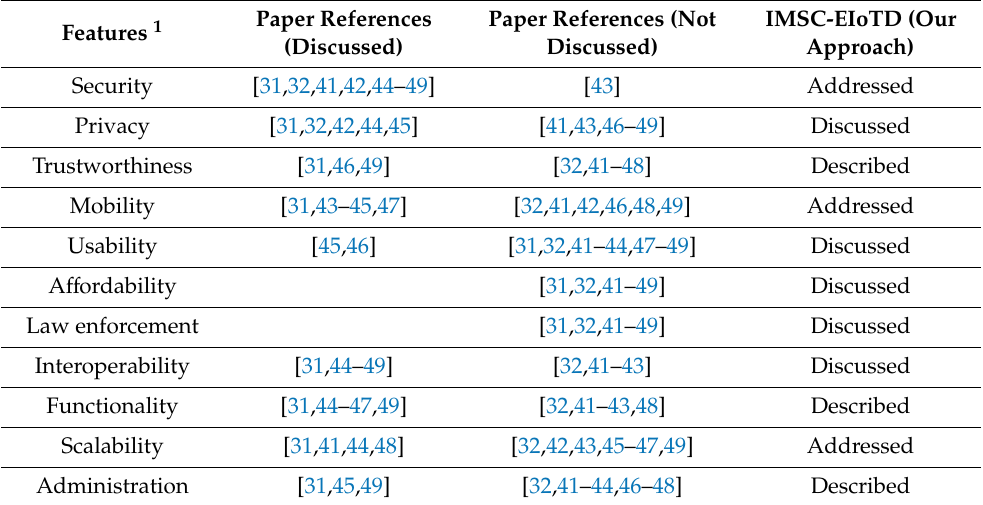
Table 2. Comparative analysis of di ff erent features of identity management